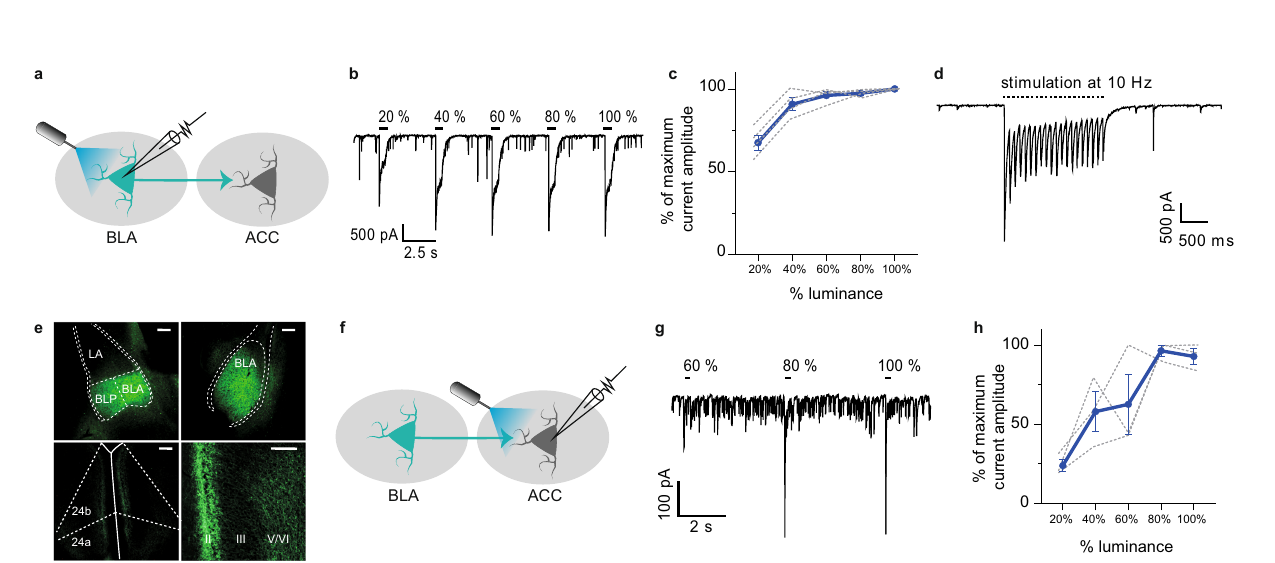
Fig. 2 | Optogenetic inhibition of the BLA – ACC pathway blocks NPID. a Graphical representation of virus delivery to the mouse BLA for voltage-clamp recordings. b RepresentativeimagesofeYFP+cellbodiesintheBLA(upperpanels) and eYFP+ axon terminals in the ACC (lower panels). Scale bars=100 µ m. c Graphical representation of patch-clamp recording in the BLA. d Representative trace of outward currents. e Amplitude of currents induced by optogenetic sti- mulations of BLA neurons ( n =5 cells/2 mice, green trace=mean; gray traces= individual responses). f Graphical representation of the experimental design for in vivo optogenetic inhibition of the BLA – ACC pathway. g , h At 3 or 6 weeks PO, mechanical hypersensitivity was not affected by the inhibition of BLA – ACC path- way(ipsivscontra;3POweeks,cuff: n =5mice, F (1,4) =7.752; P =0.0496;6POweeks, cuff: n =13 mice F (1,12) =55.80; P <0.0001; light-off vs light-on; 3 PO weeks F (1,4) =0.669; P =0.4592; 6 PO weeks F (1,12) =2.971; P =0.1104). i Optogenetic inhibi- tion of the BLA – ACC pathway did not induce a place preference at 6 weeks PO (sham-ctrl: n =5mice;sham-stim: n =4mice;NPID-ctrl: n =5;NPID-stim: n =4mice; F